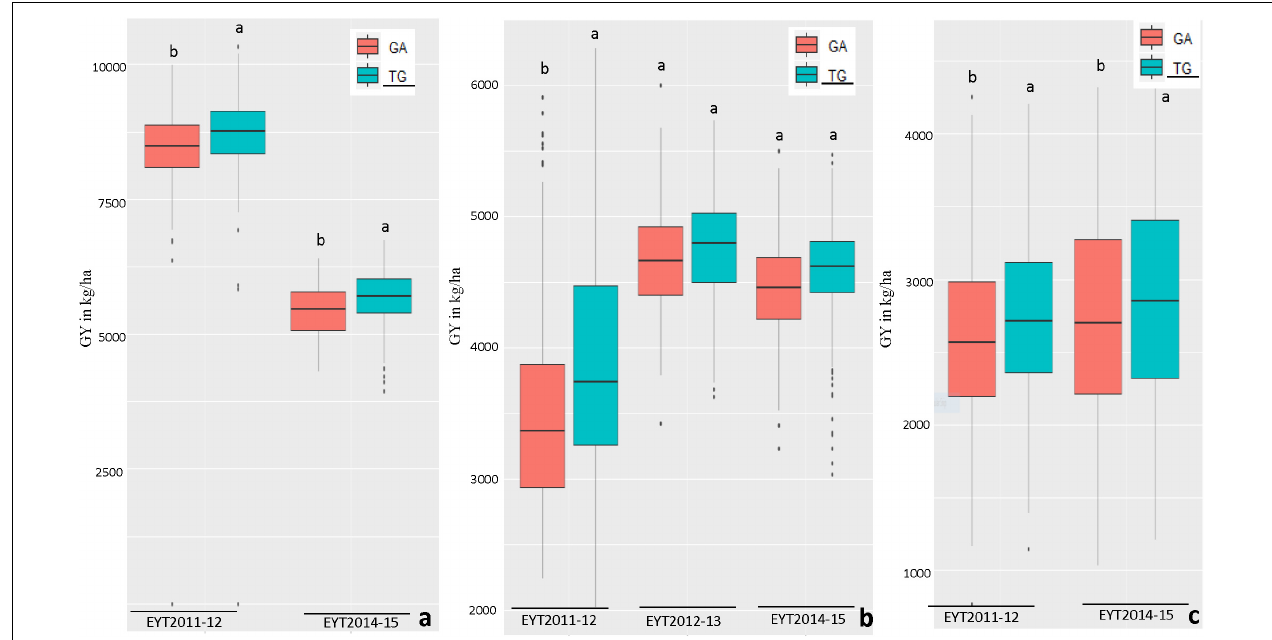
FIGURE 3 | Allelic effects of two haplotypes in HB11.4 (associated with Pi ) on GY (Y axis in kg/ha) across EYTs; TG showing the highest mean is the favorable haplotype under Bed 5IR (a) , Bed 2IR (b) , and SD (c)